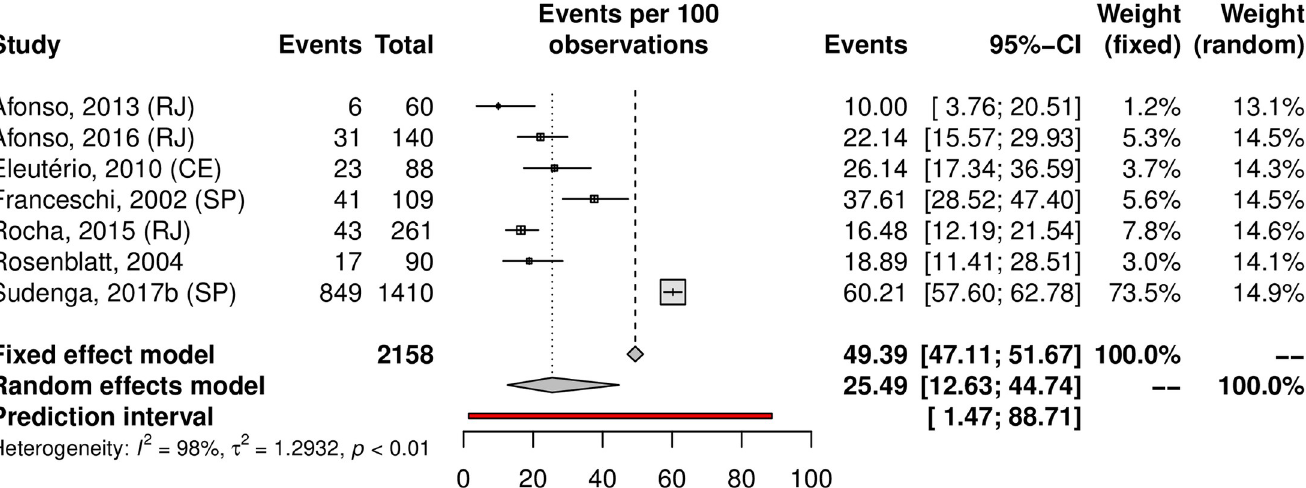
PLOS ONE | https://doi.org/10.1371/journal.pone.0229154 February 21,